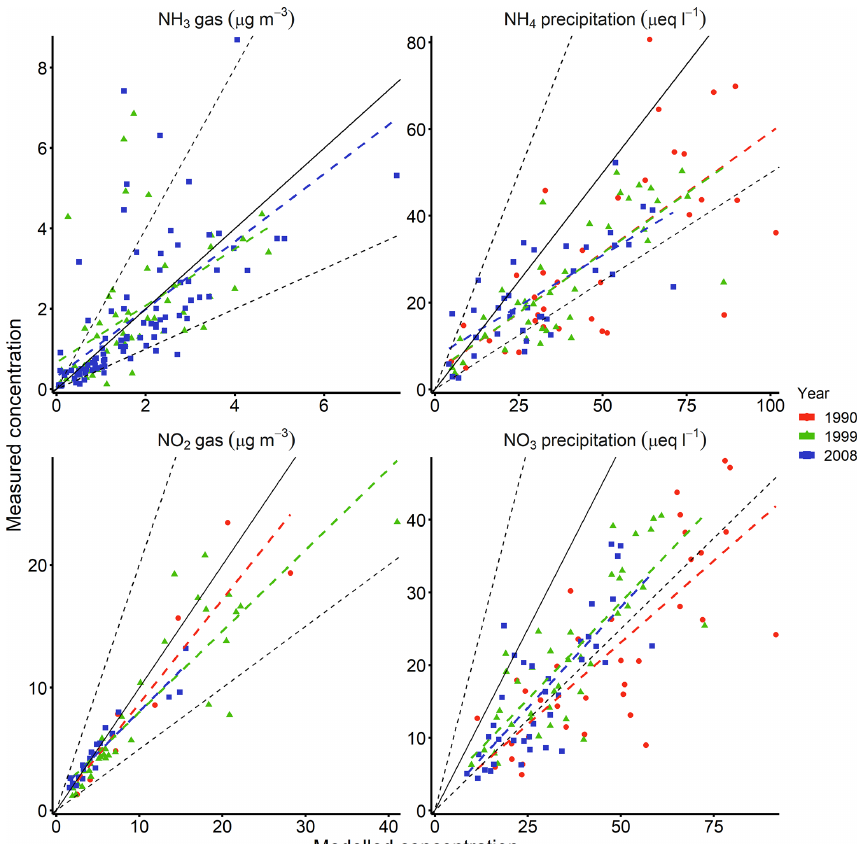
Figure 6. Evaluation of modelled ( x axis) and measured ( y axis) concentrations of four nitrogen compounds in the UK for 1990, 1999 and 2008 (see Table 3 for definitions; no NH 3 gas data exist for 1990). The solid black line represents a 1 : 1 relationship, and the dotted lines represent a factor of 2 (FAC2) relationship. The blue, green and red dashed lines are linear